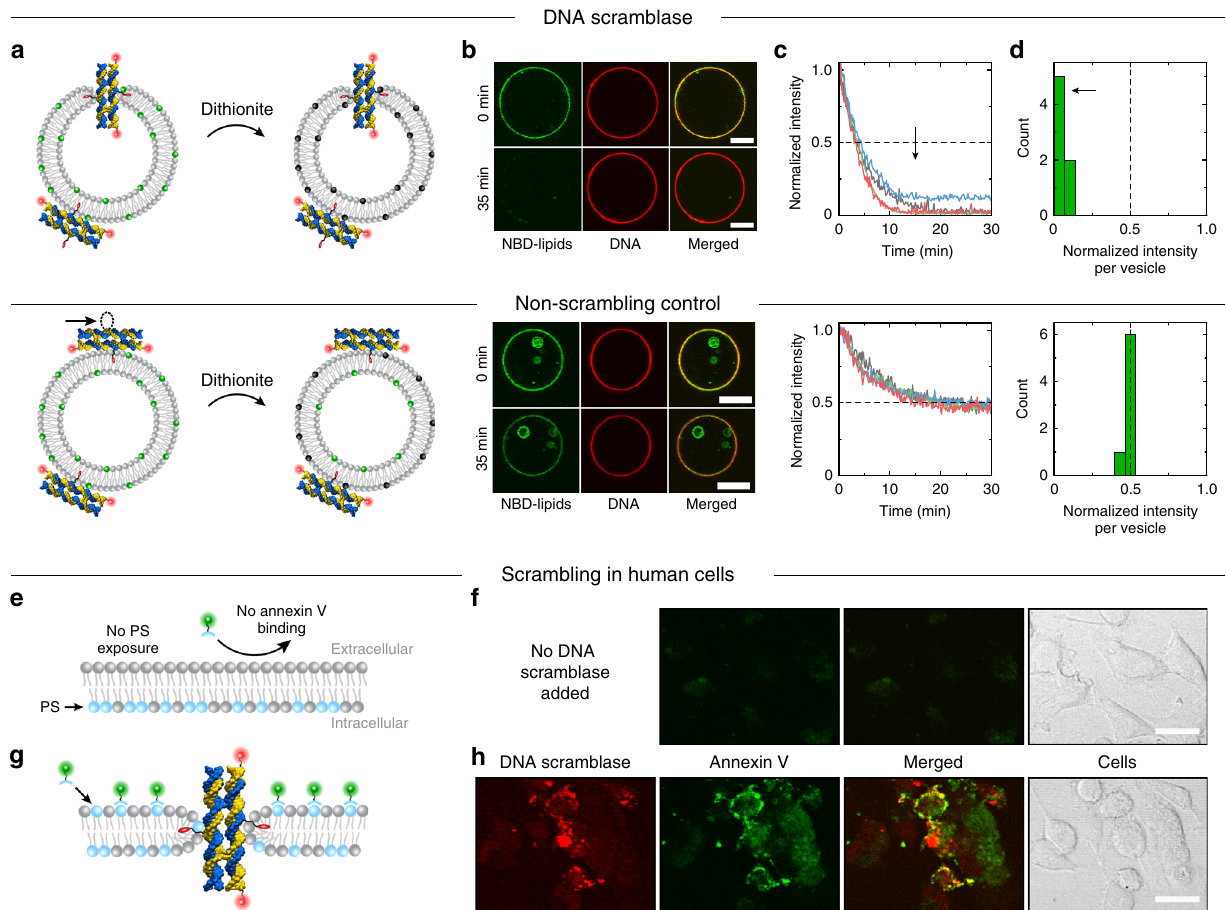
Fig. 4 Experimental demonstration of lipid scrambling by DNA nanostructures in lipid vesicles and human cells. a Schematic illustration of dithionite reduction assay. POPC (gray) vesicles containing a fraction of NBD-labeled lipids (green) are incubated with DNA constructs tagged with Cy3 dye (red spheres). Upon dithionite addition, NBD fl uorophores are irreversibly reduced (black). The nanostructure design containing two cholesterol modi fi cations (2C, top) allows for membrane insertion to induce lipid scrambling whereas the constructs with one cholesterol (1C, bottom) do not. b Confocal fl uorescence microscopy images of GUVs containing NBD fl uorophores (green) and incubated with Cy3-labeled DNA nanostructures (red) showing the same vesicle before and 35 min after dithionite addition roughly at the equatorial plane. The third column displays a merged image of the red and green channels. Scale bars are 10 µ m. c Graphs showing four representative fl uorescence intensity traces of NBD fl uorescence reduction over time for both 1C and 2C designs. Values have been normalized to the initial intensity per vesicle and aligned to the onset of dithionite reduction. d Histograms of residual NBD fl uorescence intensity at 35 min after dithionite addition normalized to the initial intensity for each vesicle. Data were obtained from four (2C) and one (1C) experiments using the same GUV stock solution. Black arrows and dashed lines in c and d highlight the shifted fl uorescence intensity values for 2C nanostructures in contrast to the 1C control. Data shown were collected from vesicles with a diameter above 6 µ m (for smaller vesicles see Supplementary Fig. 12). e , g Schematic illustration of FITC-labeled annexin V binding assay without ( e ) and with membrane-inserted DNA nanostructures ( g ). Phosphatidylserine (PS) lipids are highlighted in light blue. f , h Confocal microscopy images of fi xed cells after incubation with DNA folding buffer only ( f ) or with Cy3-labeled 2C DNA scramblases ( h ). While no annexin V binding occurs in the negative control, incubation with DNA scramblases showed cell attachment of the DNA nanostructures (red) associated with increased annexin V (green) binding (see merged signal of both channels) due to PS exposure. Corresponding bright fi eld images illustrate cell locations (scale bar is 20 µ (cid:3) 2 (cid:2) ) reduces the membrane-impermeable anion dithionite ( ½ S O 2 4 the NBD fl uorophores irreversibly. If no lipid scrambling occurs, only NBD in the outer lea fl et of the vesicle membrane is bleached, effectively reducing the fl uorescence intensity to 0.5 of its initial value. If our DNA nanostructure is present and inserted, lipids can migrate from the inner lea fl et to the outer where the NBD dyes would be reduced by dithionite resulting in the decrease of fl uorescence below 0.5 over time (Fig. 4a top).